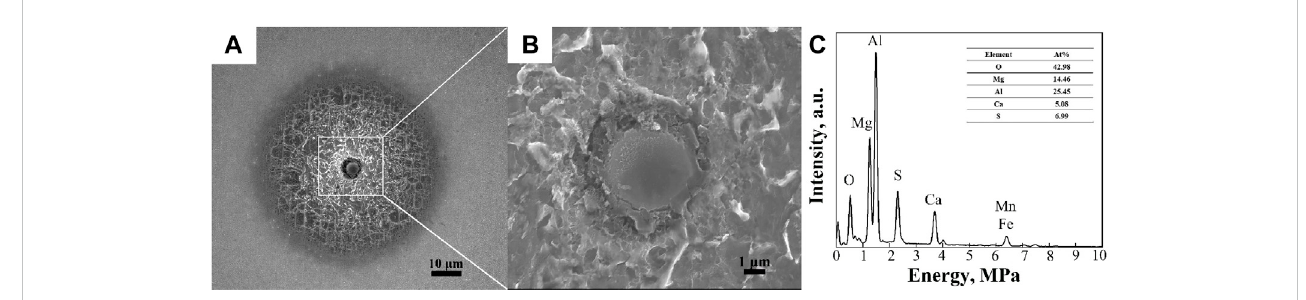
FIGURE 12 SEM morphology of corrosion in the HAZ at low (A) and high (B) magni fi cation and the EDS map (C) of the inclusion in (B) .